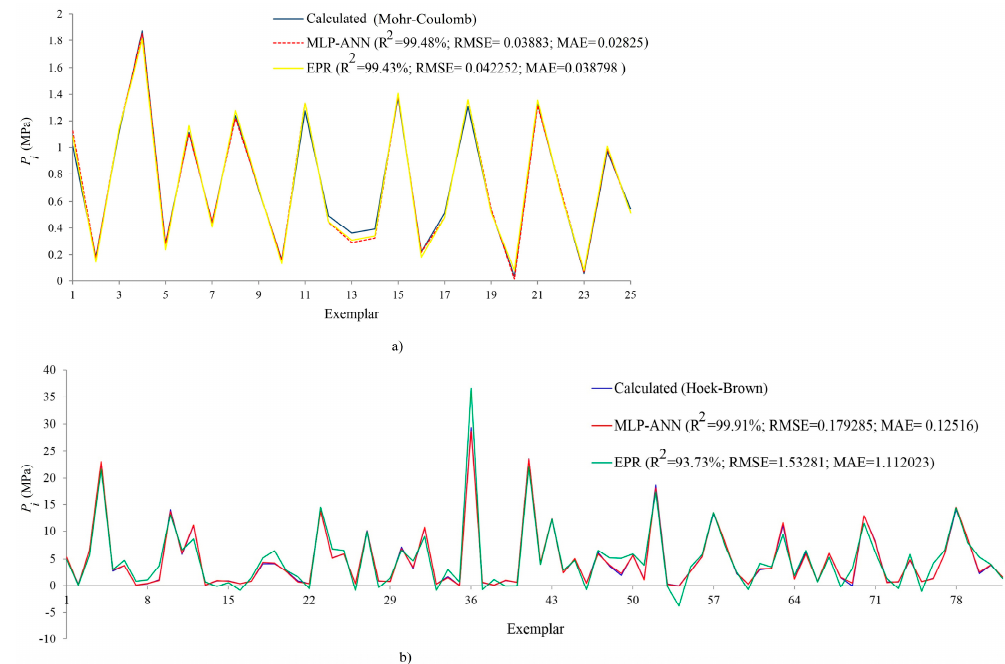
Figure 8. Comparison between the performance of ( a ) 15-5-10-1 MLP-ANN and evolutionary polynomial regression technique (EPR) model (Mohr–Coulomb case); ( b ) 17-5-15-1 MLP-ANN and EPR model (Hoek–Brown case) in the prediction of the P i